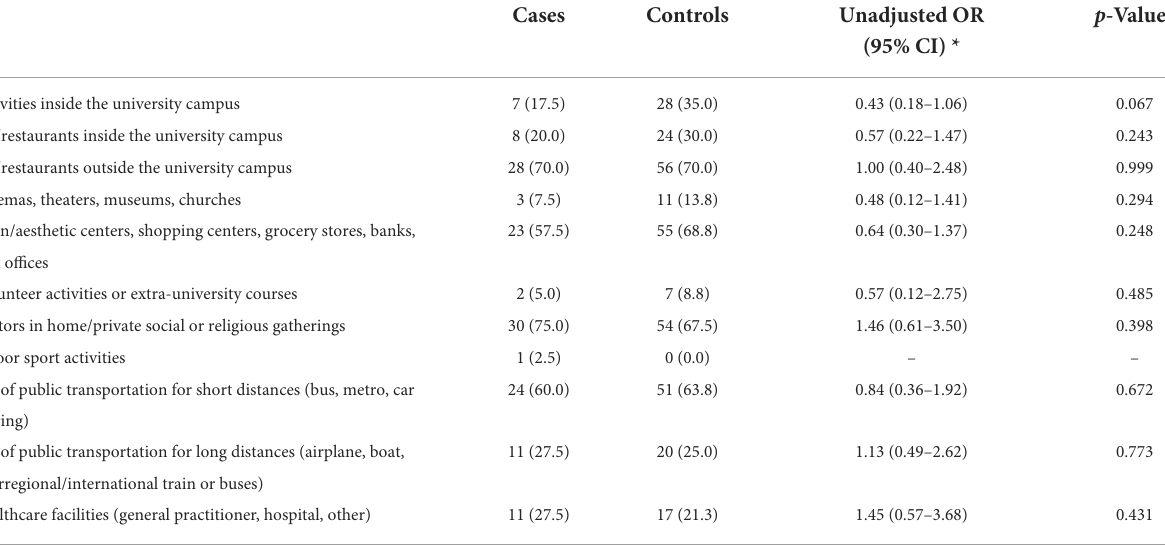
TABLE 3 Students’ activity-related exposures ≤ 14 days before testing for SARS-CoV-2.